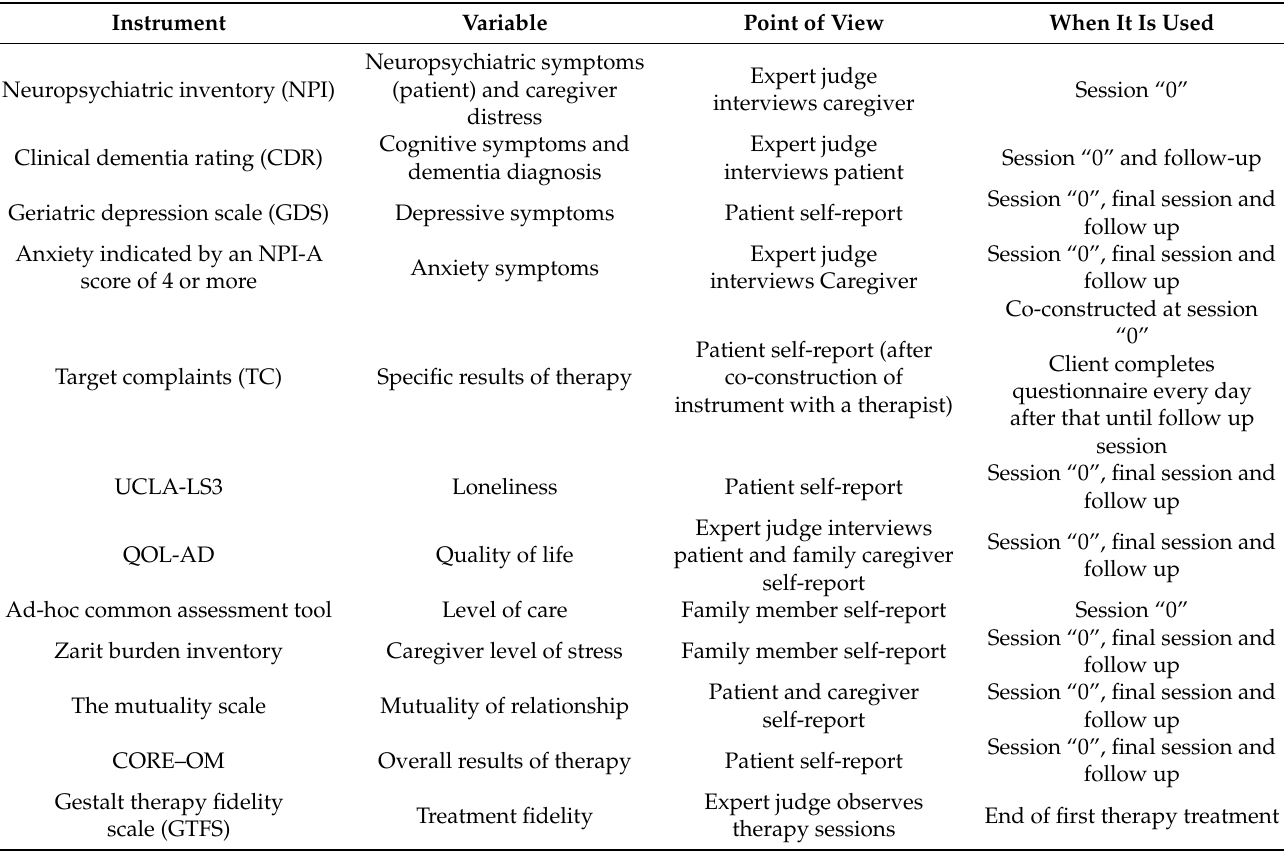
Table 1. Outcome measures with related variables, subjects involved, and time of data